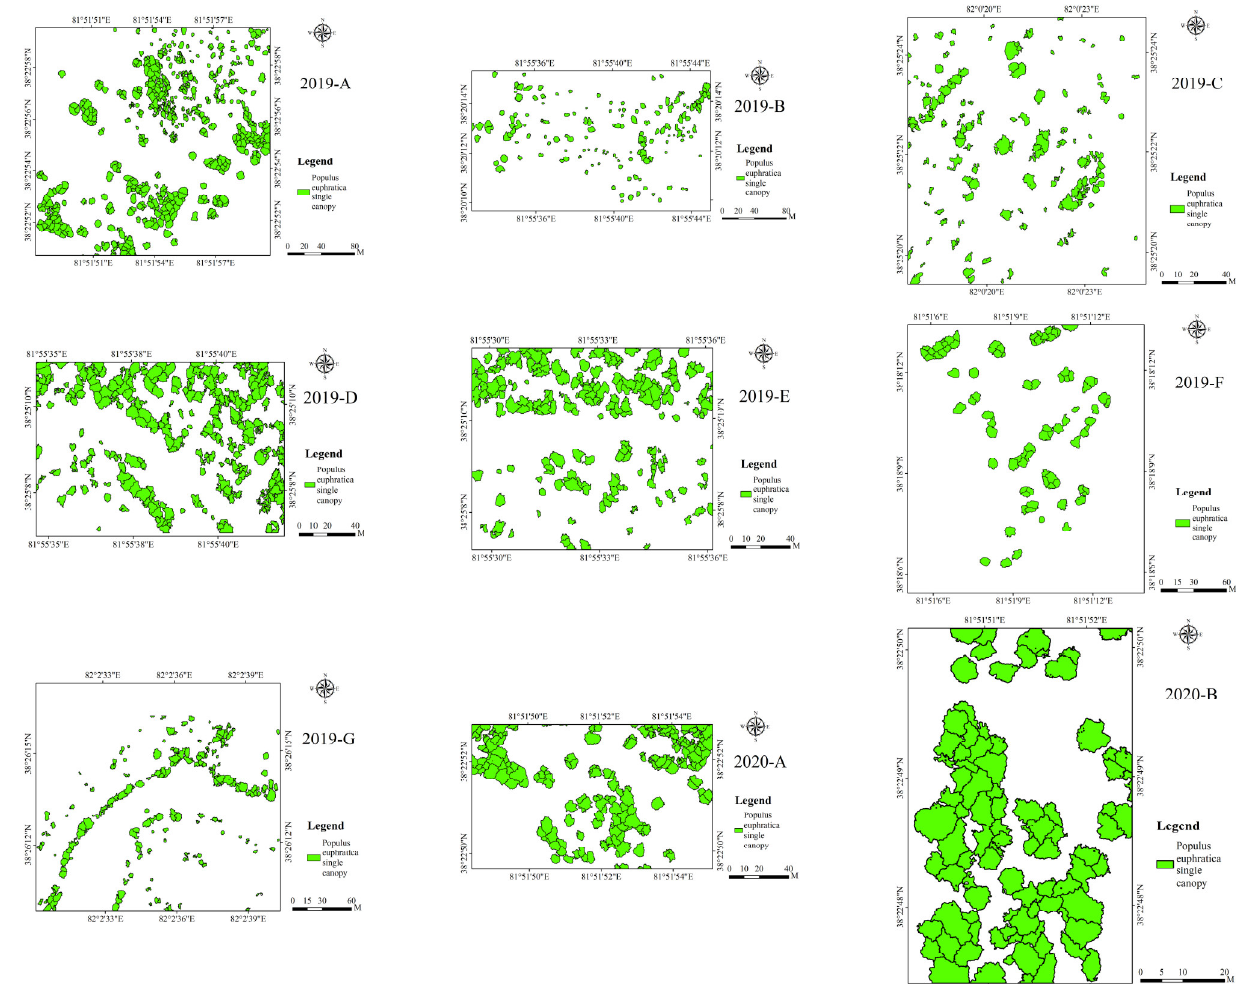
Figure 8. Segmentation vector result of PeITCs in each quadrat.